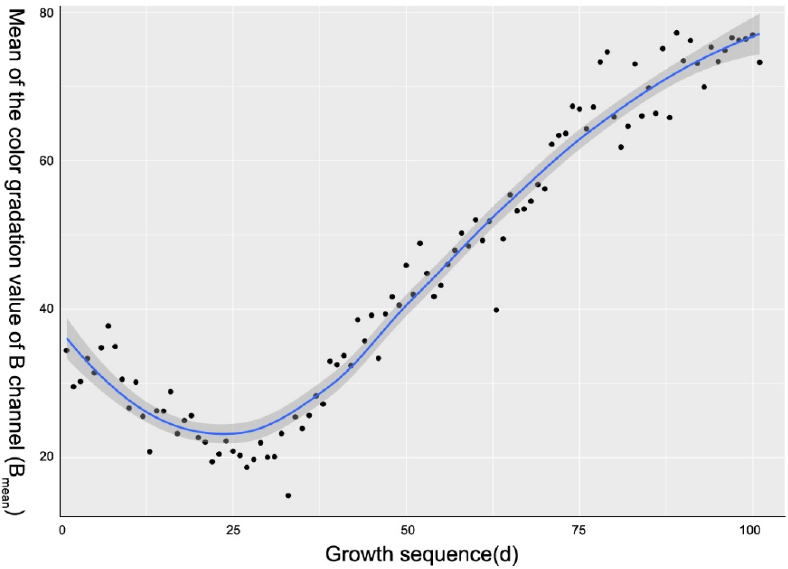
Figure 6. Scatter plot of B Means during the whole growth period of pepper. B Mean was fitted by the local polynomial regression ‐ fitting algorithm, which was implemented by the geom_smooth function of R. X axis was the sequence of daily leaf age, and Y axis was the daily value of B Mean .